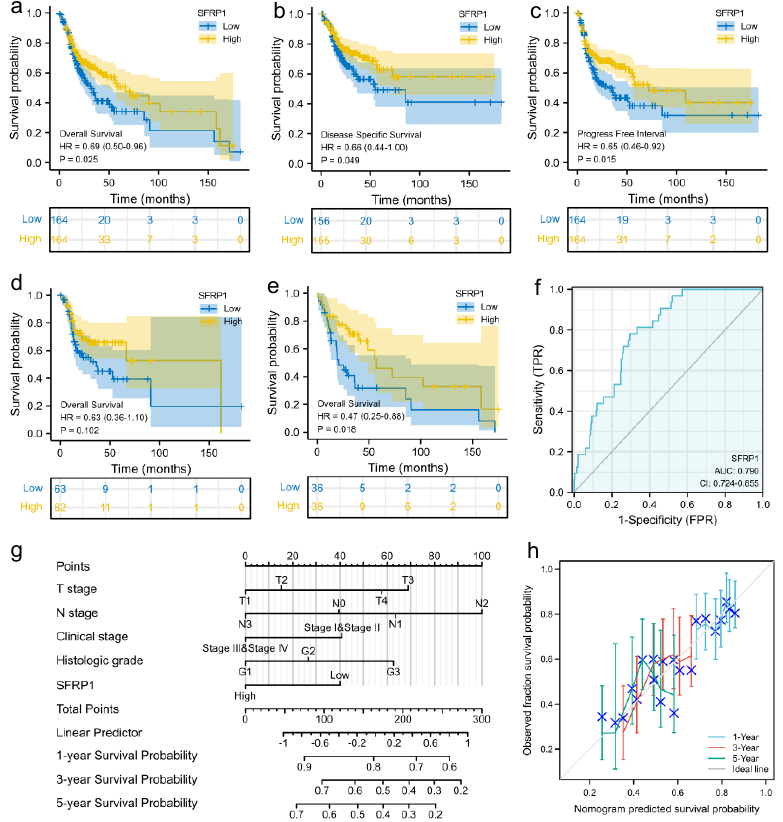
Figure 4. Prognostic analysis of various clinicopathological factors. ( a ) Kaplan–Meier survival curves in OS; ( b ) Kaplan–Meier survival curves in DSS; ( c ) Kaplan–Meier survival curves in PFI; ( d ) Kaplan–Meier survival curves in oral cavity cancer; ( e ) Kaplan–Meier survival curves in TSCC; ( f ) ROC curve showed that SFRP1 was a marker to predict the prognosis of OSCC; ( g ) nomogram used